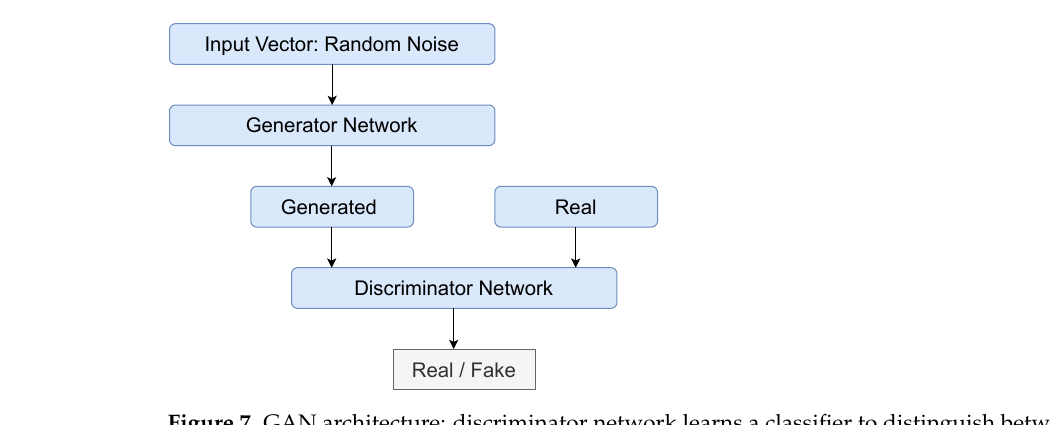
Figure 7. GAN architecture: discriminator network learns a classifier to distinguish between gener- ated and real samples. Generator network updates its parameter so that the discriminator’s task is as difficult as possible.